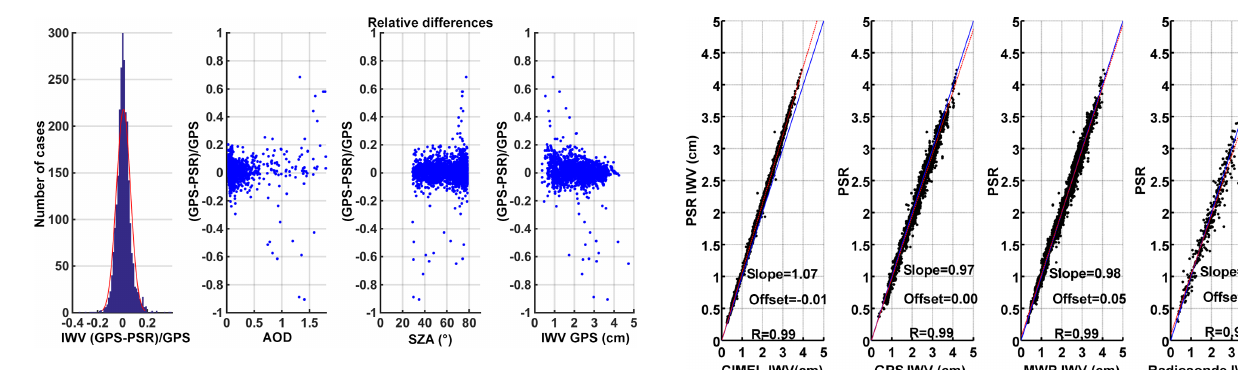
Figure 10. Histogram of relative difference among synchronous GPS and PSR retrievals – using monochromatic approach at 946nm – and plotted against AOD (retrieved from PSR at 865nm), solar zenith angle and IWV (retrieved from GPS).